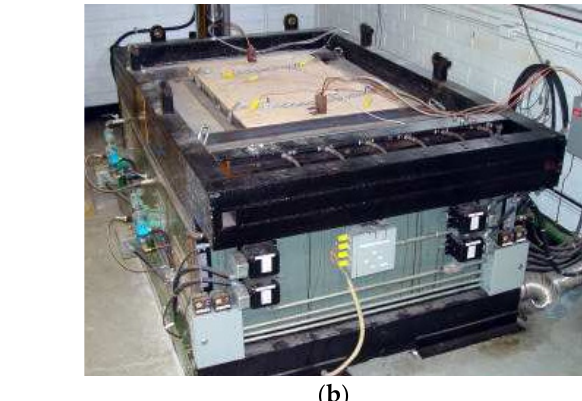
Figure 20. The full ‐ scale standard fire ‐ resistance ‐ test setup of the partition wall. Hidalgo et al. presented an investigational study considering full ‐ scale open ‐ floor ‐ plan enclosure fires. In the research, a large ‐ scale investigational sequence was assumed to create a complete data set to illustrate fire in large open ‐ plan spaces, typical of tall buildings and contemporary infrastructure [56]. Bisby et al. prepared a review covering the non ‐ standard fire ‐ resistance testing methods used by researchers to characterize the response of structural material in fire [7]. Gale et al. conferred the backgrounds of the standard fire ‐ resistance test, the boundaries within the fire testing or design, the difficul ‐ ties of the results of the real fire in buildings, and the consequential research gap that currently exist [57]. Zhang et al. presented a scheme with an ASTM E 119 fire environment in a large section (size 10 m wide, 7 m depth, and 3.8 m height), using the designed fire